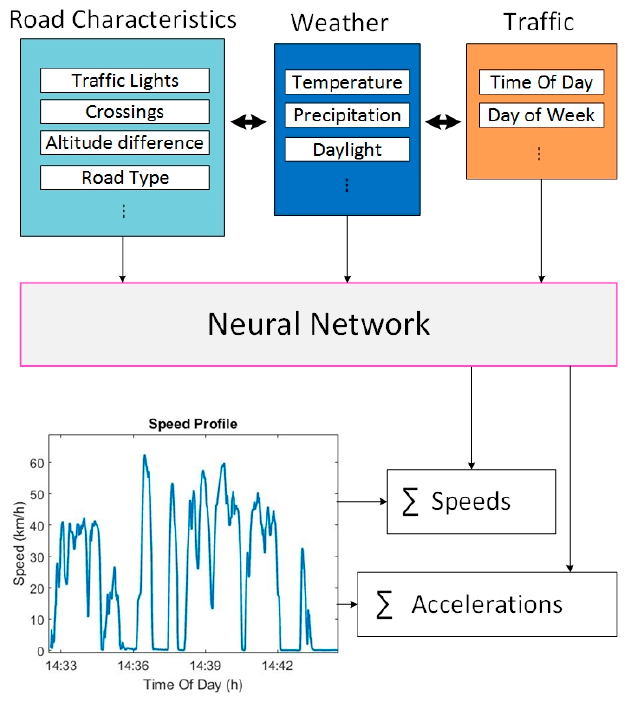
Figure 4. Schematic overview of the neural network (NN), its inputs and outputs.